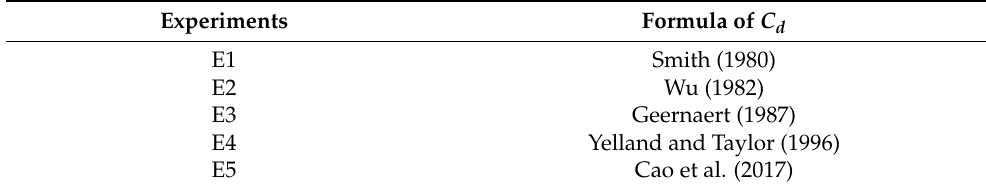
Table 2. Experiments evaluating the influence of the drag coefficient on storm surge level.